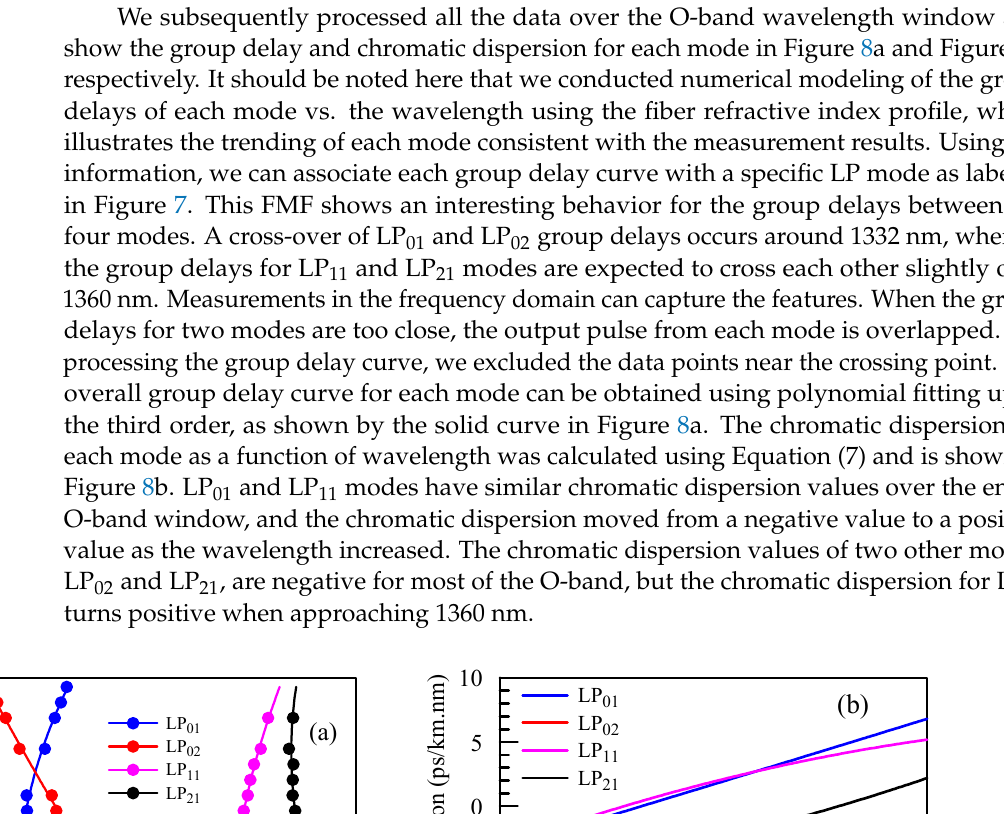
Figure 7. ( a ) The inverse Fourier transform of the real part of CTF measured at 1270 nm; ( b ) modified CTF defined in Equation (4), CTF’; ( c ) the calculated output pulses for the 4-mode FMF.